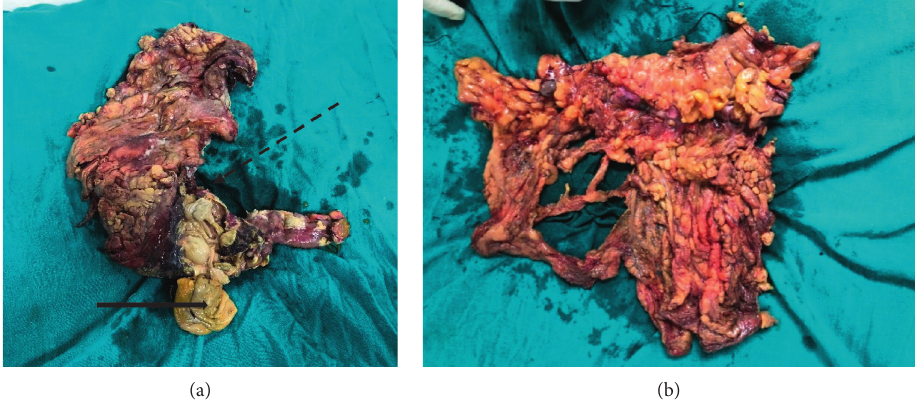
Figure 2: (a) Resected bowel segment showing the gangrenous ascending colon (dashed arrow) and sloughed off caecum (bold arrow). (b) Resected transverse colon with mesocolon (gangrenous with multiple